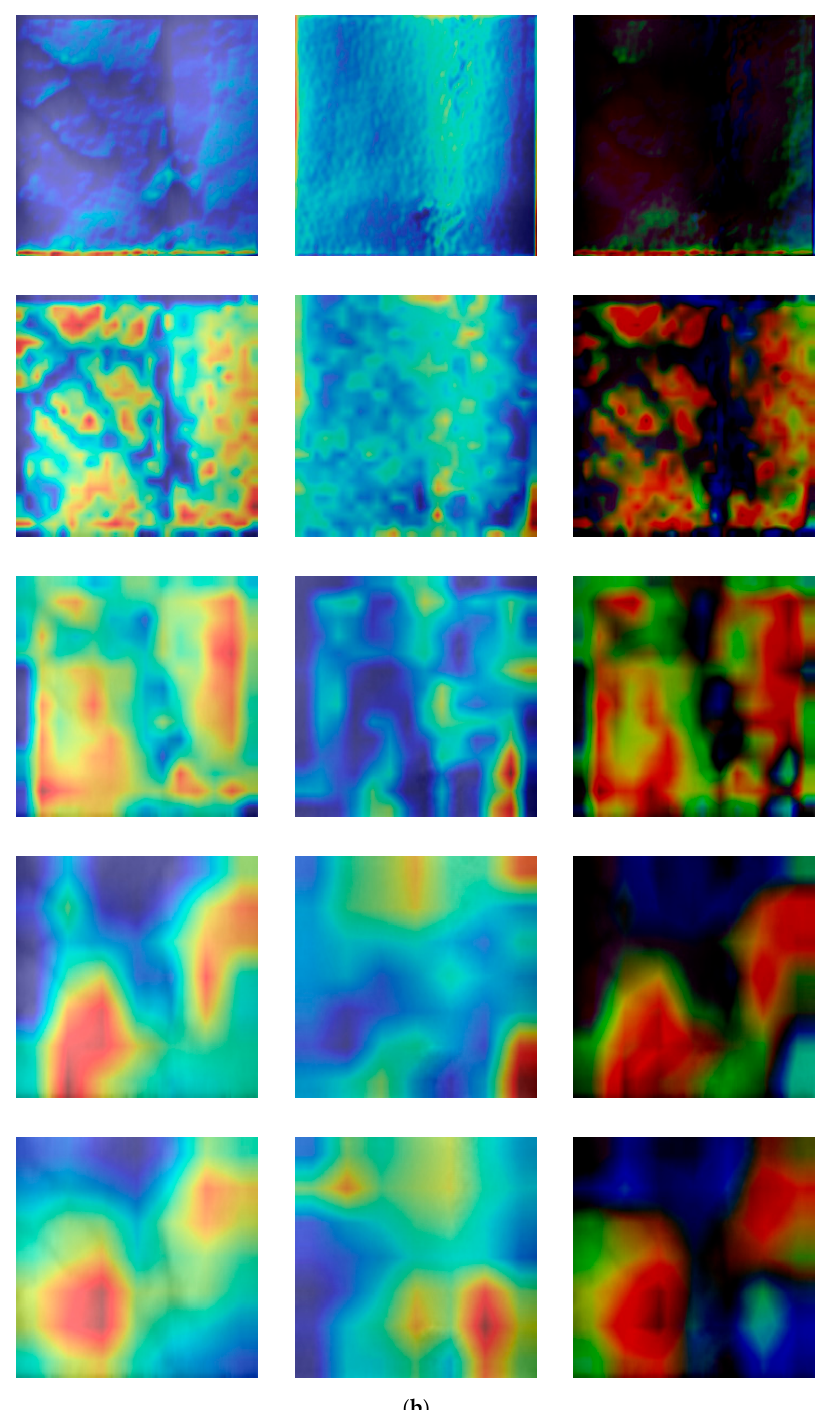
Figure 21. Comparisons of the class activation maps between the original and restored images. ( a , b ) are examples of authentic and imposter images, respectively. Images on the left of ( a , b ) are the original images, whereas those on the middle are the restored image by proposed modified DeblurGAN. In addition, the images on the right of ( a , b ) are the subtracted ones of the middle image from the left one. For both ( a , b ), the images from top to bottom are the class activation maps output from the 1st convolutional layer, the 1st transition layer, the 2nd transition layer, the 3rd transition layer, and the last dense